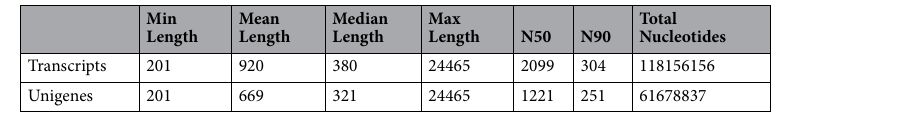
Table 2. Assembly statistics of C. Ciliata